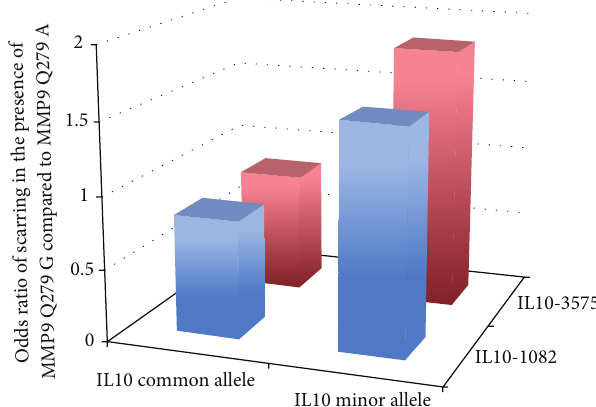
Figure 2: Evidence for MMP9-IL10 epistasis in Gambians with tra- chomatous scarring. The protective effect of MMP9 allele (Q279R) is modulated by host genetic background at the IL10 locus such that protective effects of the G allele are lost in the presence of either of 2 minor frequency risk alleles ( IL10 -1082C or IL10 -3575A). The interaction between these nonallelic genes (or risk genotypes) has a dominant effect over other combinations. The interaction between risk genotypes was examined by conditional likelihood ratio tests (LRT) (main effects) log p/1 − p = a + b (SNP1) + c (SNP2). Interaction terms were defined as Log p/1 − p = a + b(SNP1) + c(SNP2) + d(SNP1 ∗ SNP2) and when significant identified statistical epistasis. This approach was applied to 651 Gambian case-control pairs of TS. The MMP9 Q279R and IL10 -3575 loci showed strong evidence for statistical interaction affecting risk of TS (LRT 𝜒 2 = 7.23 , 𝑃 = 0.007 ). Carriers of the (protective) MMP9 Q279R G allele who also had the IL10 -3575A minor allele were at significantly increased risk of TS (OR = 1.83 (1.06–3.19)) when compared to subjects with the IL10 -3575 T allele (common allele) (OR =